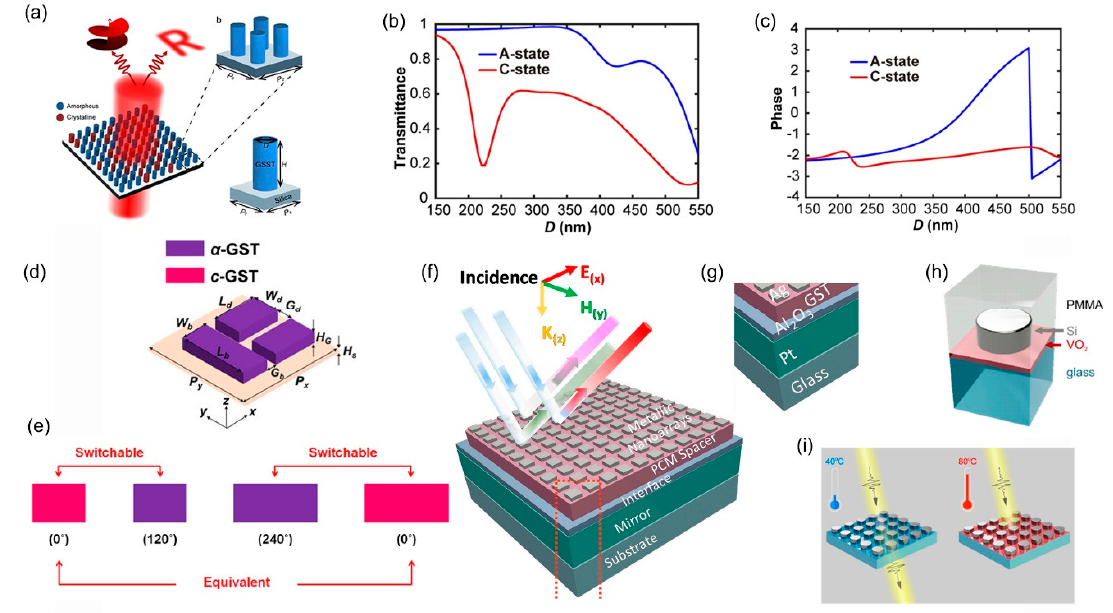
Figure 2. ( a ) The schematic of the tunable metasurface based on GSST (from Figure 1a–c of Ref. [107]). ( b , c ) The amplitude and phase responses of the metasurface. (from Figure 1d,e of Ref. [107]). ( d ) The schematic of an active dielectric metasurface based on GST (from Figure 4a of Ref. [108]). ( e ) Three different phase responses of 0 ◦ ,120 ◦ and 240 ◦ (from Figure 5b of Ref. [108]). ( f , g ) Schematic diagram of a perfect metasurface absorber based on GST thin film (from Figure 1a,b of Ref. [109]). ( h ) The schematic of a tunable dielectric metasurface based on VO 2 (from Figure 1a of Ref. [110]). ( i ) Two states of GST under different temperatures (from Figure 1b of Ref. [110]). Reproduced with permission from Ref. [107] under a